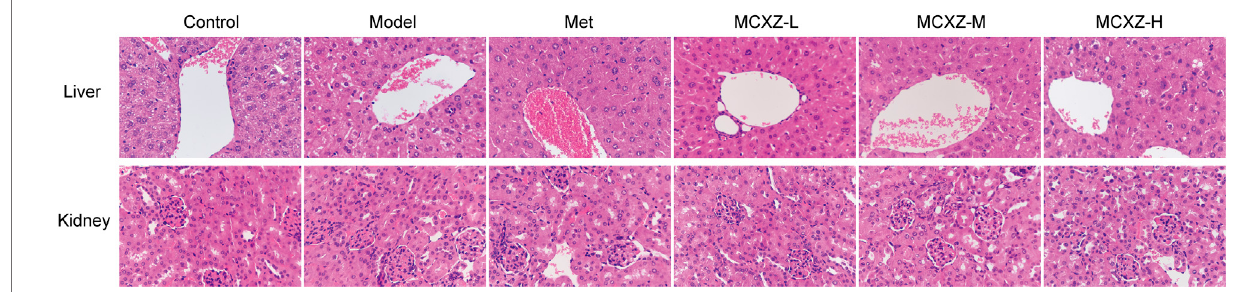
FIGURE 3 | The effects of MCXZ on liver and kidney histopathological injury ( × 40).